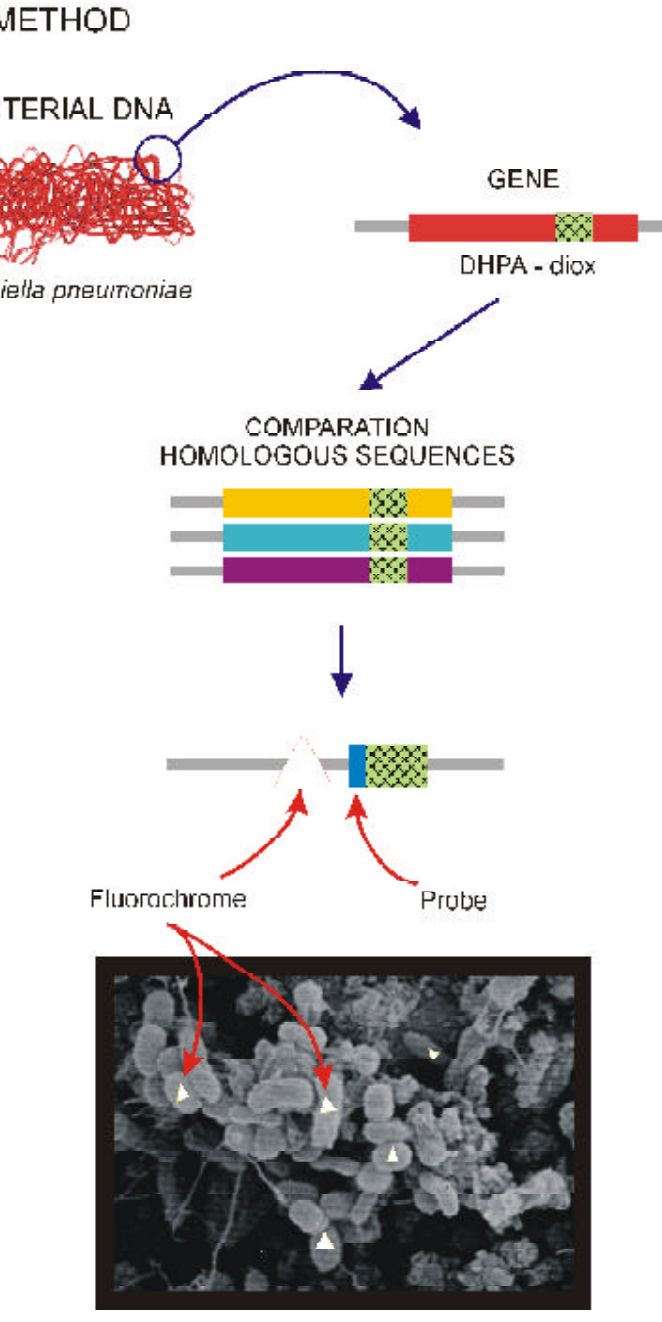
FIGURE 1. The FISH method: selective molecular probes based on 3,4-dihydroxyphenylacetate dioxigenase (DHPA diox), were assayed to detect aromatic compounds–degrading bacteria in soil